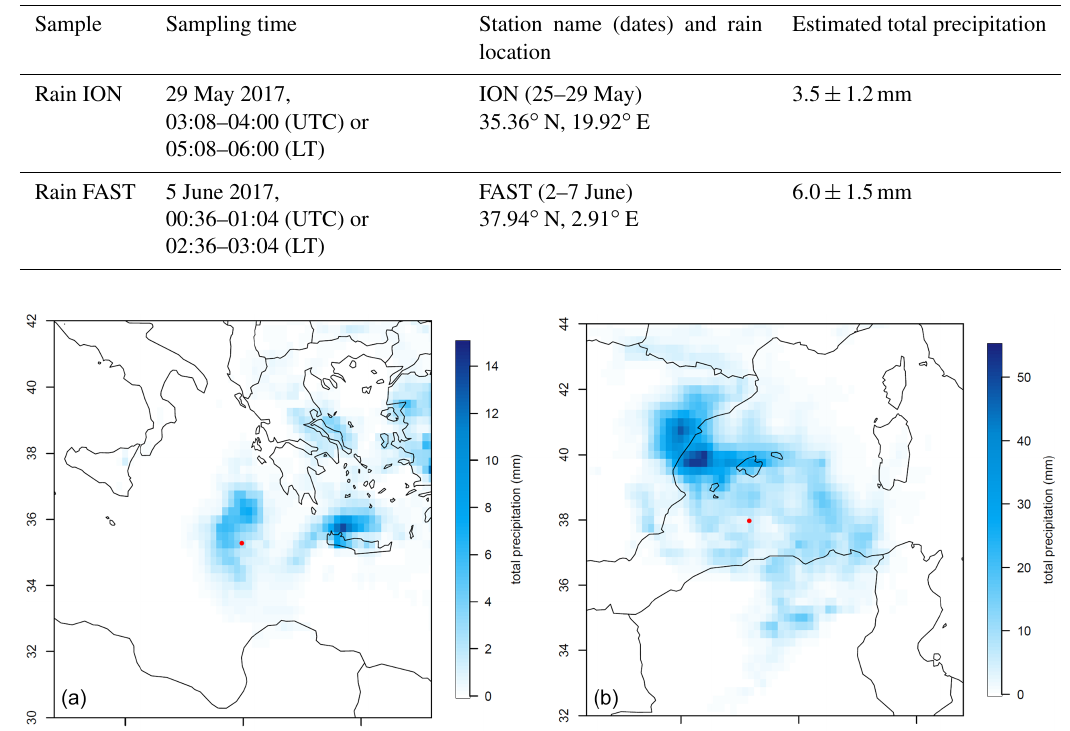
Table 1. Information regarding the two rains datasets collected during the PEACETIME cruise.